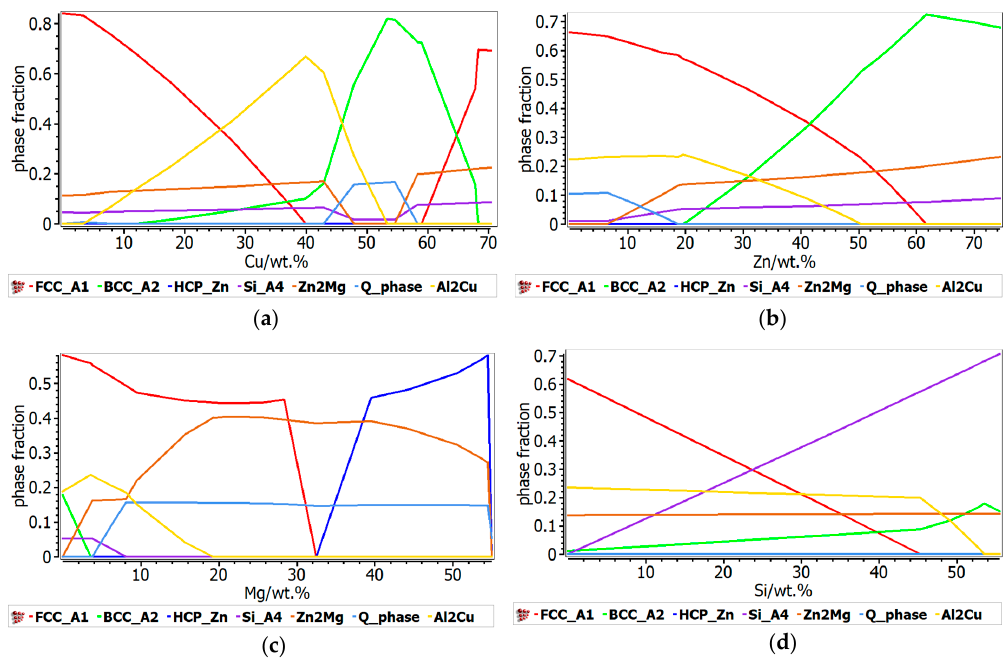
Figure 6. Influence of the element content over the phase stability in Al 3.4 Cu 0.5 Si 0.2 Zn 0.5 Mg 0.2 : ( a ) Cu influence; ( b ) Zn influence; ( c ) Mg influence; ( d ) Si influence.